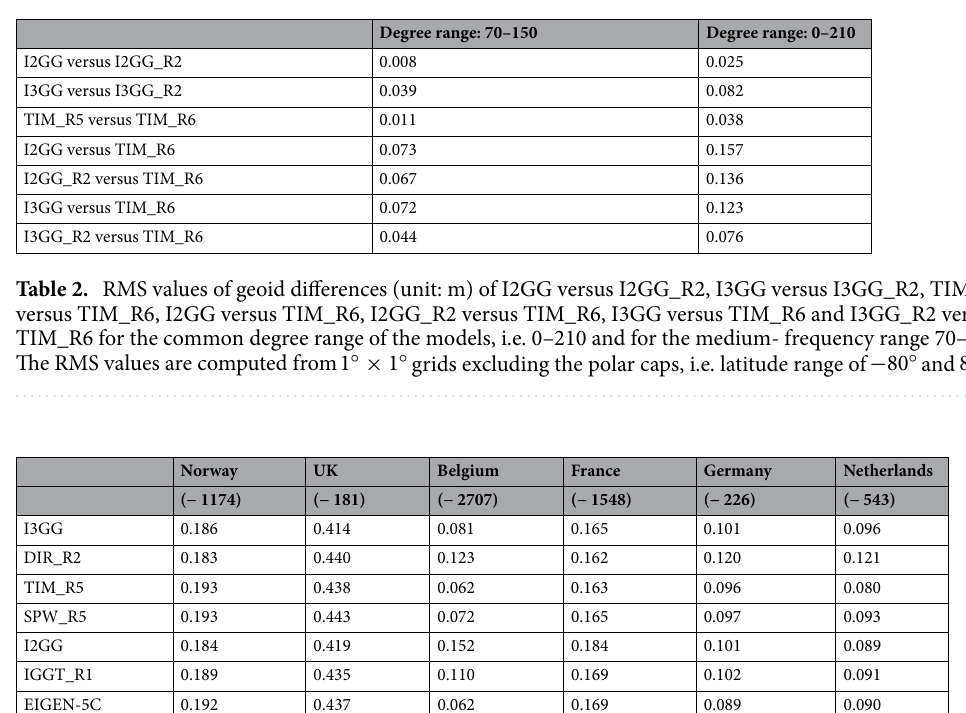
Table 3. The RMS difference (unit: m) between GNSS/leveling data in Norway, UK, Belgium, France, Germany and Netherlands and the model-derived geoid heights on the basis of EIGEN-5C and the GOCE- derived models I3GG, DIR_R2, TIM_R5, SPW_R5, I2GG, IGGT_R1 (number of points in brackets, for maximum d/o